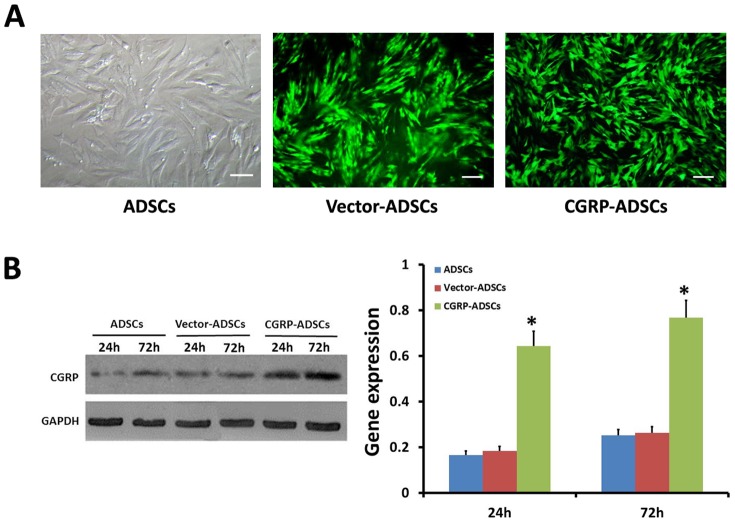
Overexpression of CGRP in genetically modified ADSCs.(A) The transduction efficiency was determined using flow cytometry at 72 h after transduction. Scale bar equals 100 µm. (B) The expression of CGRP among all groups was detected on days 1 and 3. *p<0.05, CGRP-ADSCs group vs. controls.